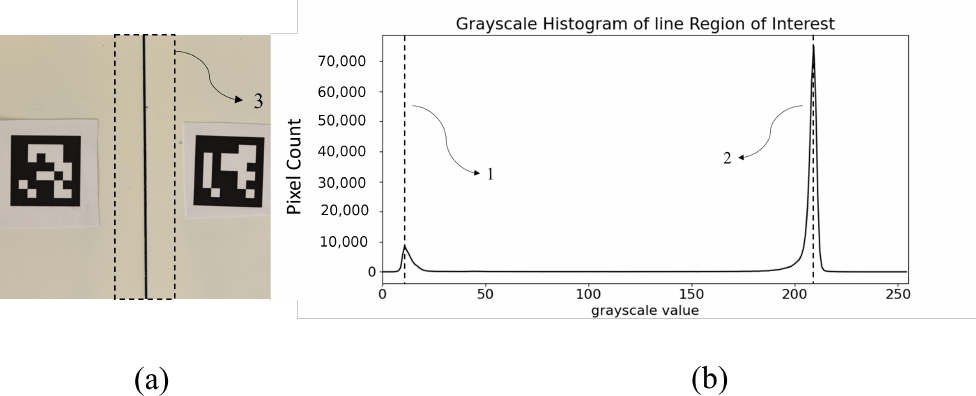
Figure 30. Histogram ( b ) of the grayscale image ( a ) of the area of interest, including the groove under test (3). Two main peaks can be identified in the histogram. On the left, the peak representing the area belonging to the groove (1); and on the right, the peak representing the area belonging to the background (2).